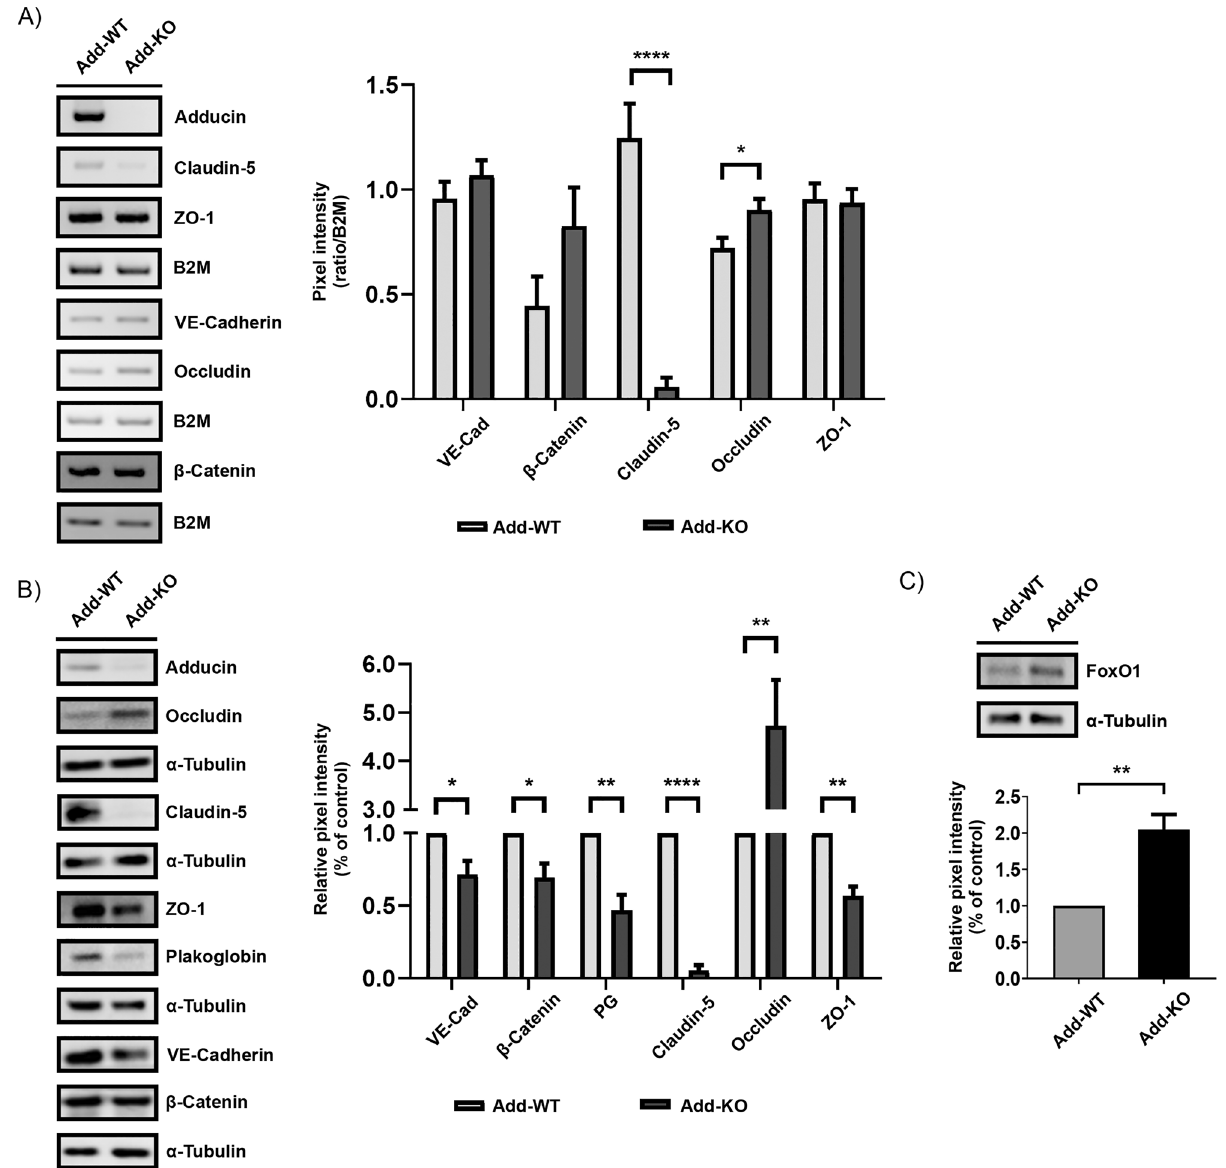
Figure 2. Protein and mRNA expression analysis of junctional and junction-associated molecules. ( A ) Representative RT-PCR for AJ and TJ components from confluent WT and Add-KO monolayers under basal conditions. The graph shows the pixel intensity ratio for each and the corresponding loading control, B2M (N = 8 per group). ( B ) Representative Western blot of junctional and junctional-associated molecules. The graph denotes the ratio between the pixel intensity for each protein and α-tubulin normalized to the respective WT control (N = 5 per group). ( C ) Representative Western blot for the claudin-5 transcriptional repressor FoxO1. The graph presents the relative pixel intensity normalized to the WT controls (N = 4). Data are represented as mean ± SEM; * p < 0.05; ** p < 0.01; **** p < regular (Fig. 5C, arrows). In contrast, cells lacking Add showed no claudin-5 reorganization after F/R, exhibiting areas with missing claudin-5 signal and drastically fragmented staining for the tight junctional protein, similarly to the vehicle-treated cells (Fig. 5C, arrows). Interestingly, in WT monolayers induction of cAMP changed the pattern of ZO-1 from a thin and semi-discontinuous junctional distribution to partially thicker staining in combination with finger-like extensions (Fig. 5C, arrows and arrowheads, respectively). However, the junctional distribution of ZO-1 in Add-KO cells appeared irregular and fragmented and no important effect was observed following F/R application (Fig. 5C, arrows). The protein level of the above-mentioned molecules after induction of intracellular cAMP was also investigated and no significant alterations were detected in WT cells (Fig. 5D). The outcome was similar for Add-KO cells (Fig. 5D). We hypothesized that the lack of cAMP-mediated barrier strengthening and junctional reorganization seen in Add-KO cells was associated with altered cAMP concen- tration; therefore, a cAMP ELISA assay was performed. Surprisingly, under control conditions, the difference